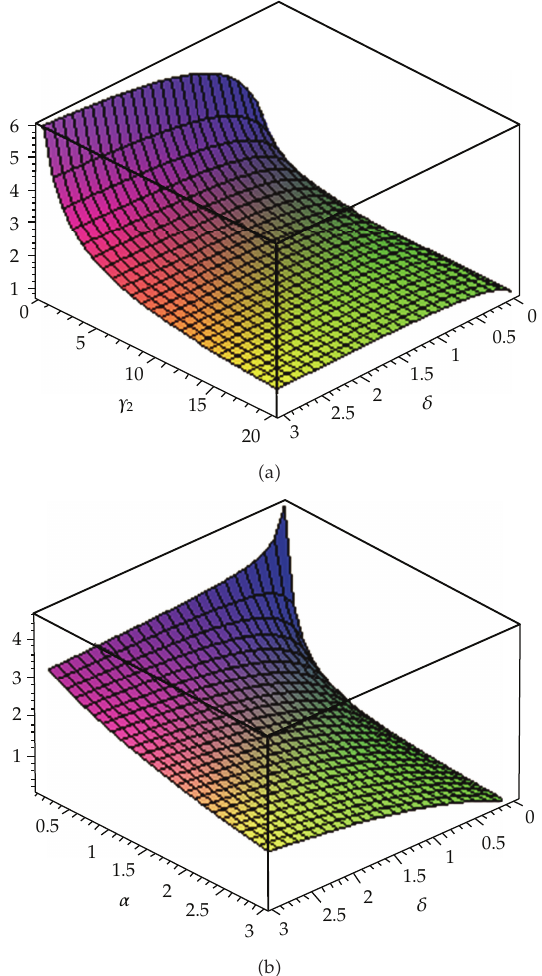
Figure 5: The graphs of the basic reproduction number R 0 in terms of some parameters: (cid:2) c (cid:3) R 0 in terms of β and δ , for the remaining parameter values are the same as Figure 3; (cid:2) d (cid:3) R remaining parameter values are k (cid:8) 0 . 04, and the others are the same as Figure